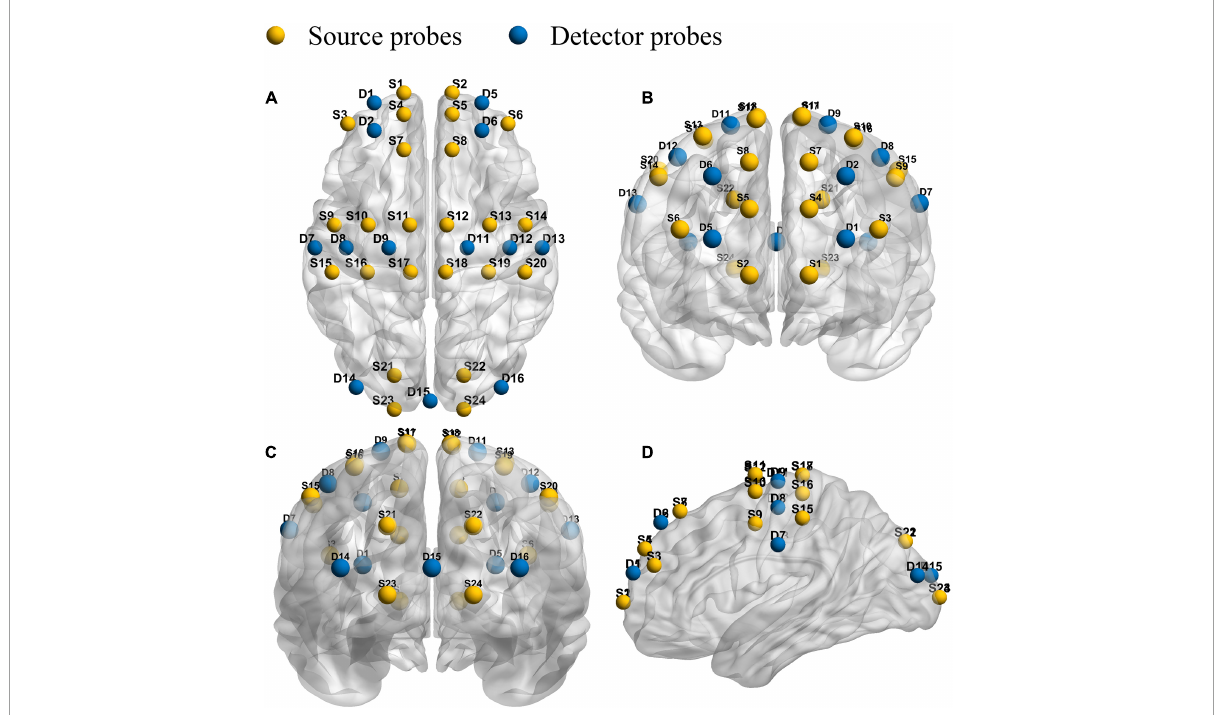
FIGURE1 Schematic diagram of the fNIRS. Configuration of 24 source probes, 13 detector probes and 40 measurement channels. The top view (A) , the front view (B) , the rear view (C) , and the side view (D)